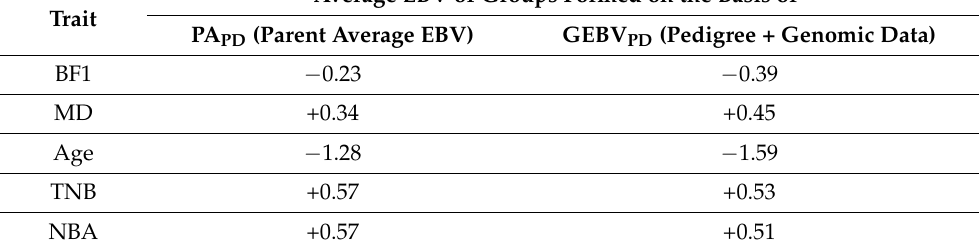
Table 7. Average breeding value (EBV) of groups formed based on PA and GEBV (by groups of validating animals). Average EBV of Groups Formed on the Basis of * Trait PA PD (Parent Average EBV) GEBV PD (Pedigree + Genomic